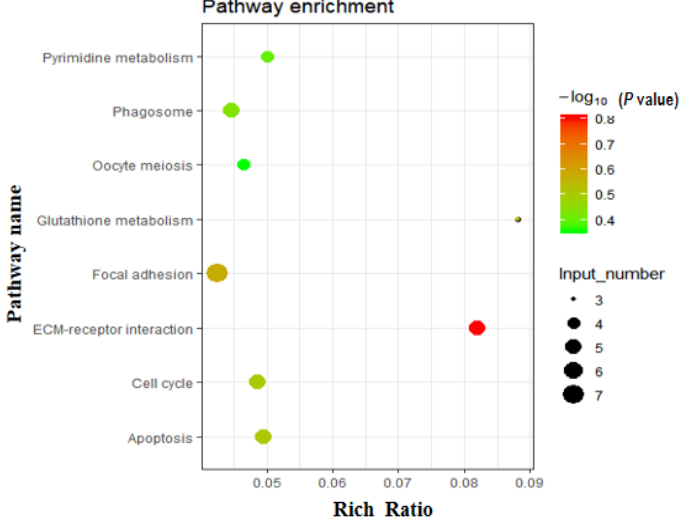
Figure 2. Enriched pathways based on the 256 DEGs. KEGG (Kyoto Encyclopedia of Genes and Genomes) pathway analysis of DEGs showed that various fat metabolism pathways (glycerolipid metabolism, steroid biosynthesis, etc.) were enriched ( p < 0.05).